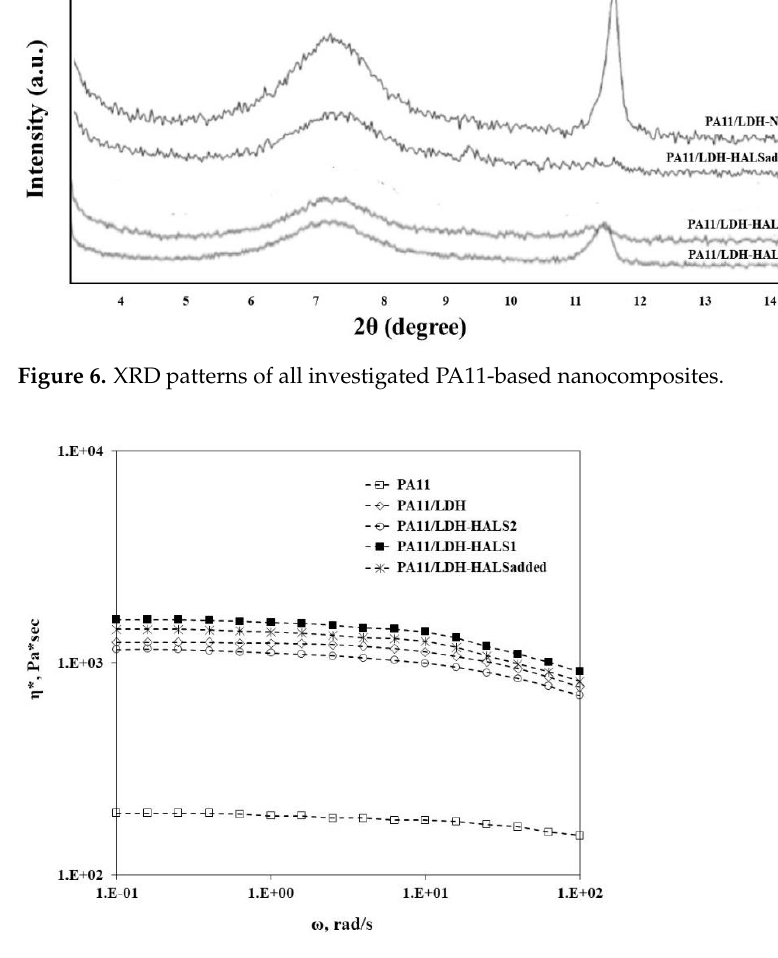
Figure 7. Viscosity curves ( η *) of neat PA11 and all investigated PA11-based nanocomposites.